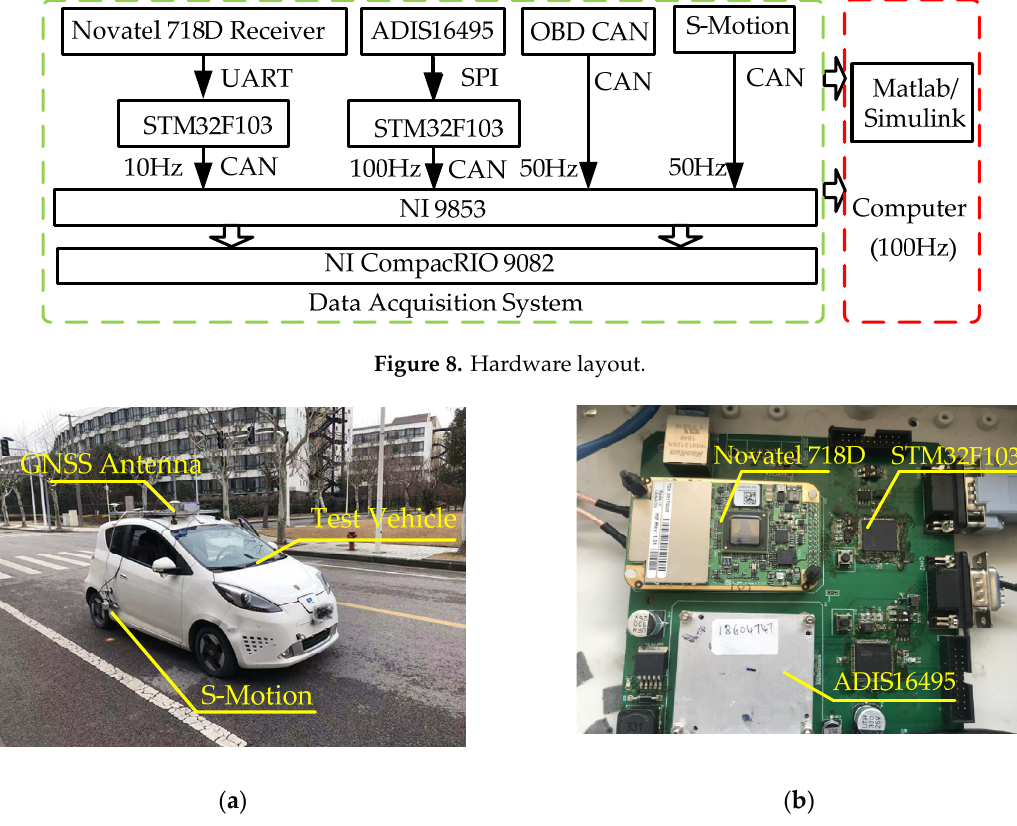
Figure 9. Hardware implementation: ( a ) test vehicle and part of equipment; ( b ) GNSS receiver and IMU.